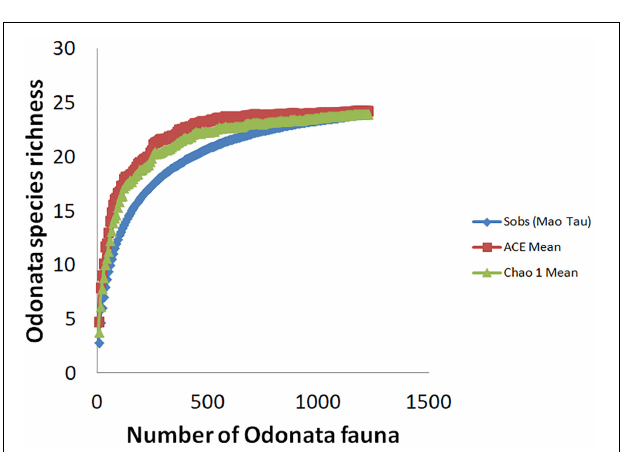
FIGURE 3 | Species accumulation curves, with the x-axis showing the number of individuals